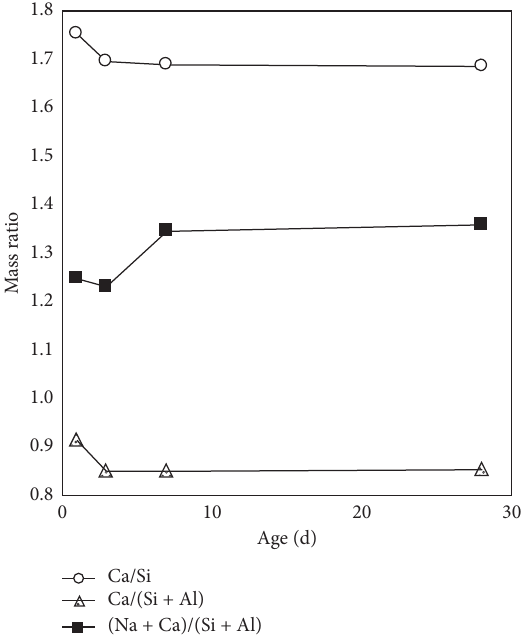
Figure 11: Mass ratio analysis of elements in an alkali-activated nickel slag activated with NaOH.